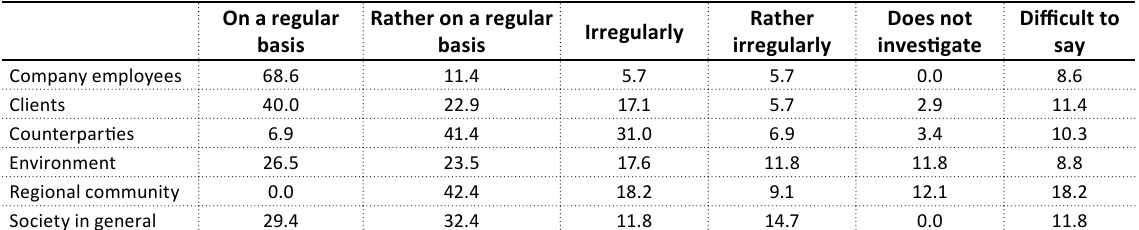
Table 1. The influence on which stakeholder groups should be investigated by insurance companies in the course of the CSR activity, %